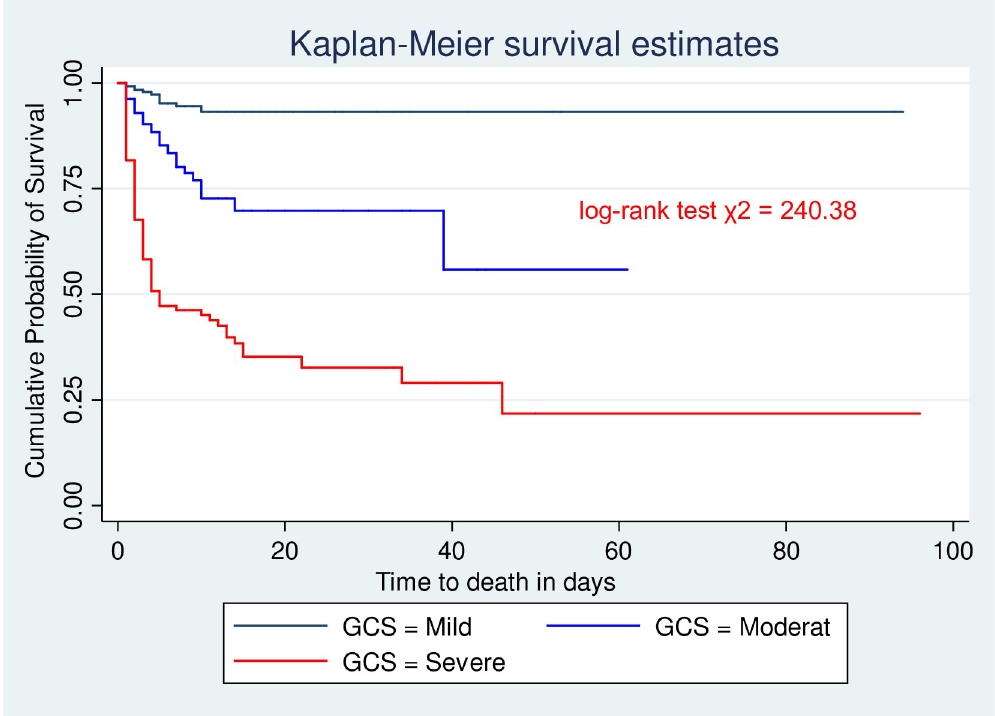
Fig 2. Kaplan-Meier survival estimate for initial GCS among head injury admitted to HUCSH, Hawassa, Southern Ethiopia; from July 2017 to July 2019.